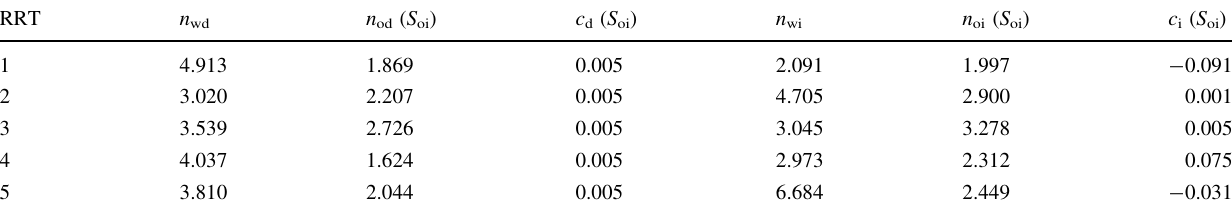
Table 8 Fitting parameters of K r correlation for RRTs